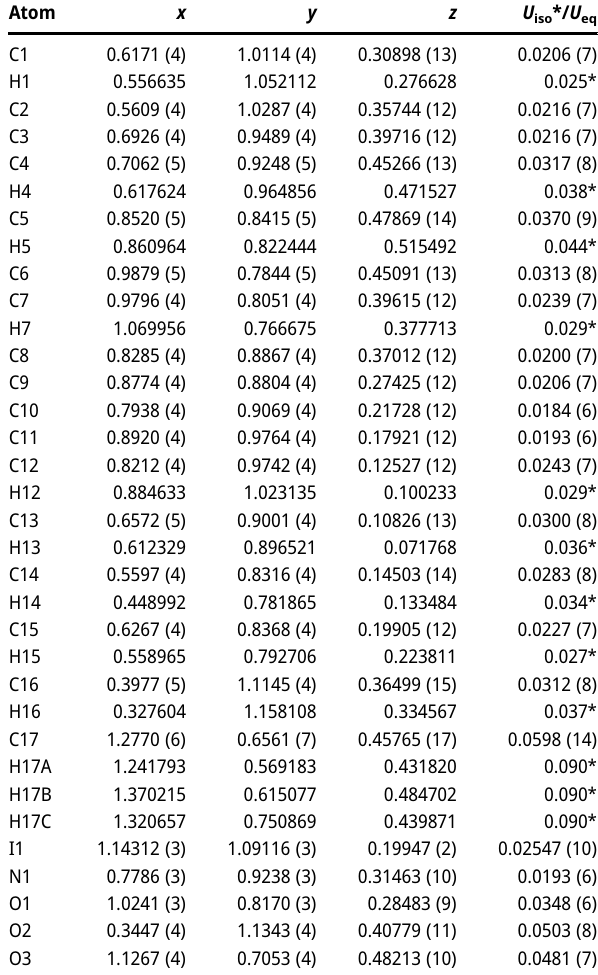
Table  : Fractional atomic coordinates and isotropic or equivalent isotropic displacement parameters (Å 